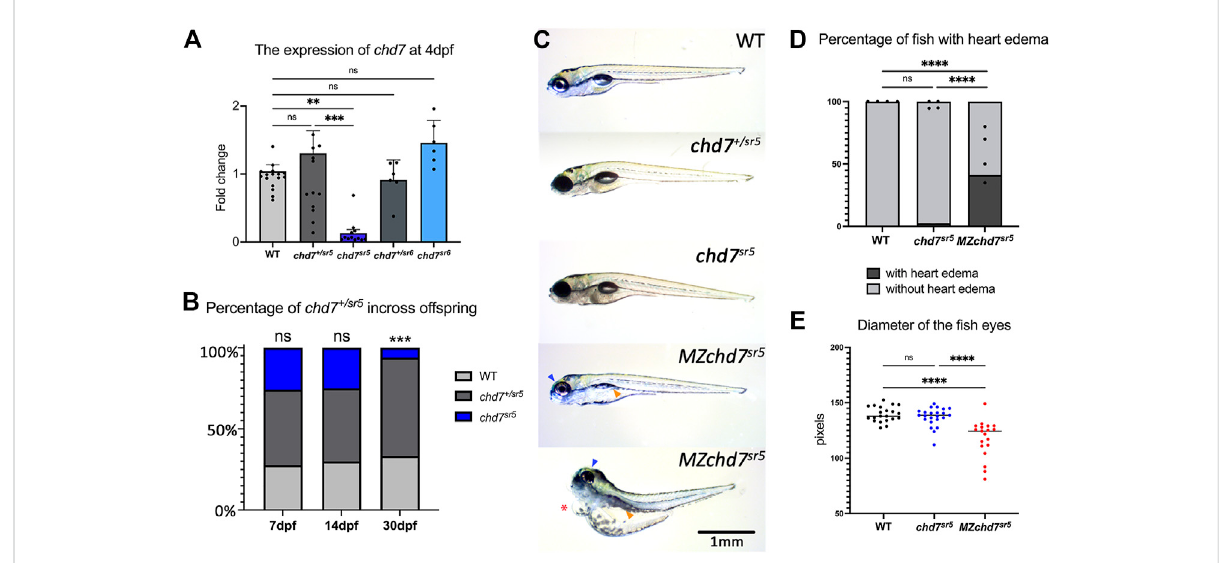
FIGURE 2 Overallphenotypesof chd7 mutants. (A) Expressionof chd7 in chd7 sr5 and chd7 sr6 larvaeat4dpf.Thefoldchangeof chd7 expressioncompared to WT was shown. (B) Percentage of the surviving offspring from chd7 sr5 incross ( n > 40 for each time point). (C) Bright fi eld images of chd7 sr5 and MZchd7 sr5 mutants at 7 dpf. MZchd7 sr5 fi sh have a smaller swim bladder (yellow arrowhead), pericardial edema (red asterisk), and small eyes (blue arrowhead). (D) Quanti fi cationofheartedema.Nearly40%of MZchd7 sr5 fi shhaveheartedema;however, chd7 sr5 fi shdonotshowheartedema phenotypes. WT: n = 879, chd7 sr5 : n = 747, MZchd7 sr5 : n = 751. (E) Quanti fi cation of the small eye phenotype. The longest diameter of the dissected eye was measured. The eye size of the MZchd7 sr5 mutants is signi fi cantly reduced ( n = 22 for each group). Statistical analyses were performed using the ordinary one-way ANOVA test for (A,E) and chi-square test for (B,D) . ns: p ≥ 0.05, *: p < 0.05, **: p < 0.01, ***: p < 0.001, and ****: p <